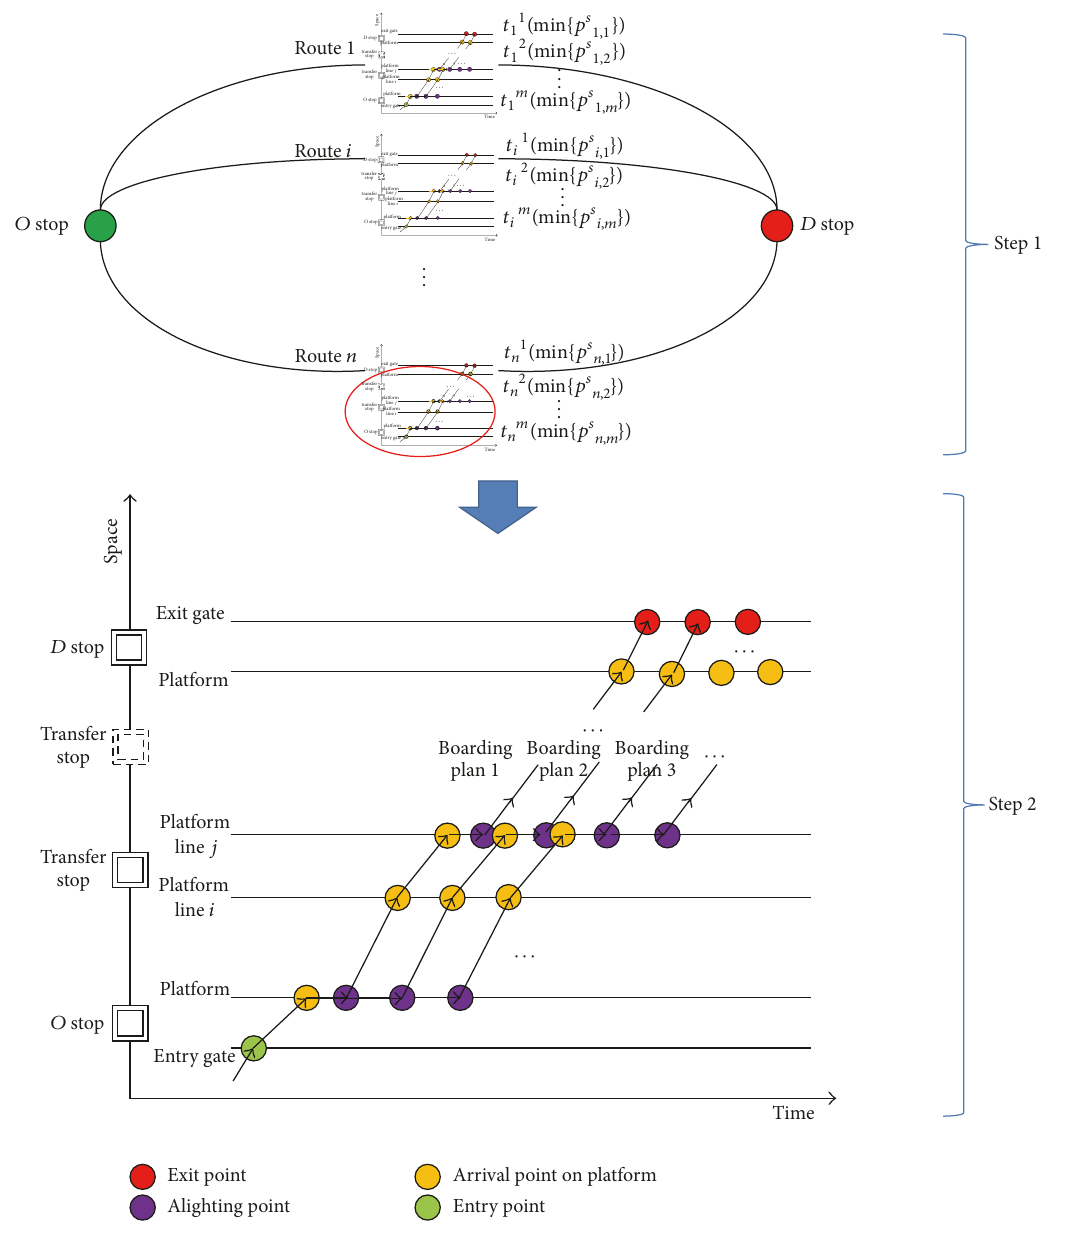
Figure 4: Illustration of two-step universal set